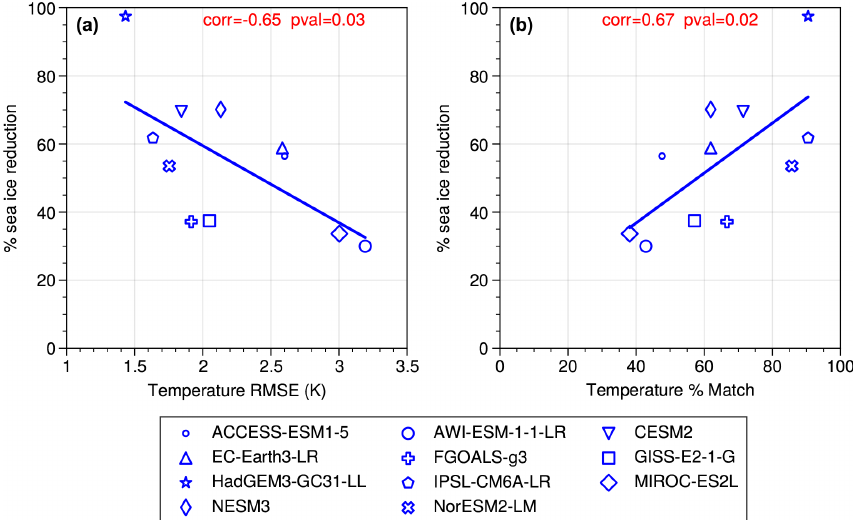
Figure A4. Modelled percentage sea ice area reduction from the LIG to the PI period versus model skill to simulate proxy (cid:49) SSAT. (a) The modelled percentage SIA reduction is scattered against the RMSE of the modelled (cid:49) SSAT compared to the proxy (cid:49) SSAT for the 21 data locations. (b) The modelled percentage SIA reduction scattered against the percentage of (cid:49) SSAT data points that the model can match (see Sect. 2).